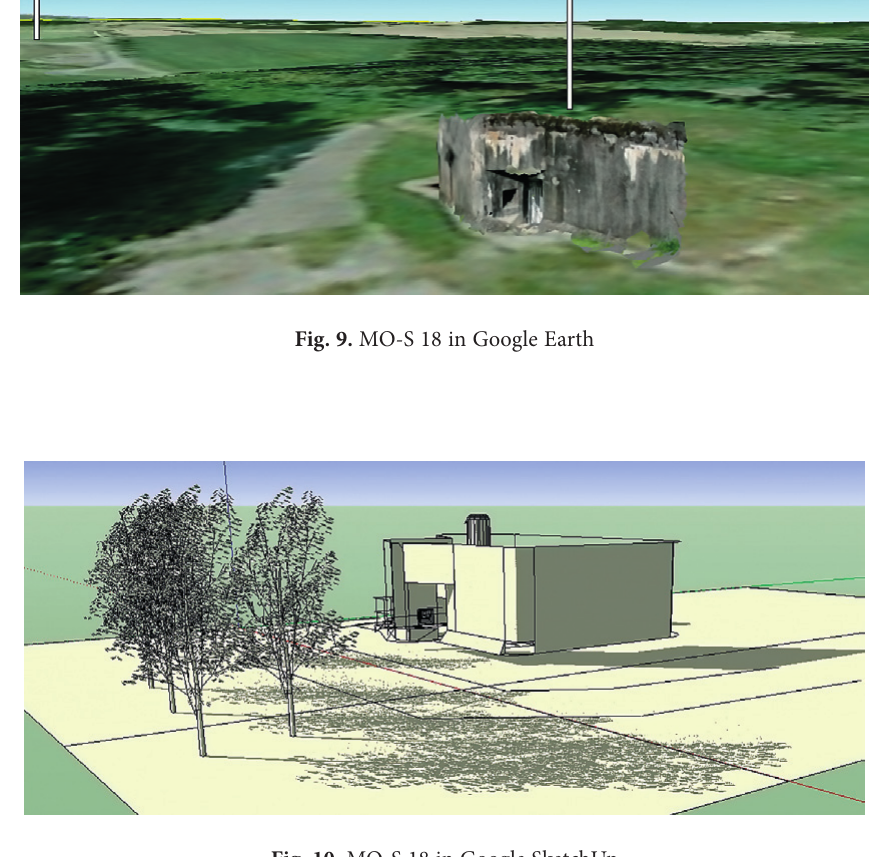
Fig. 10. MO-S 18 in Google